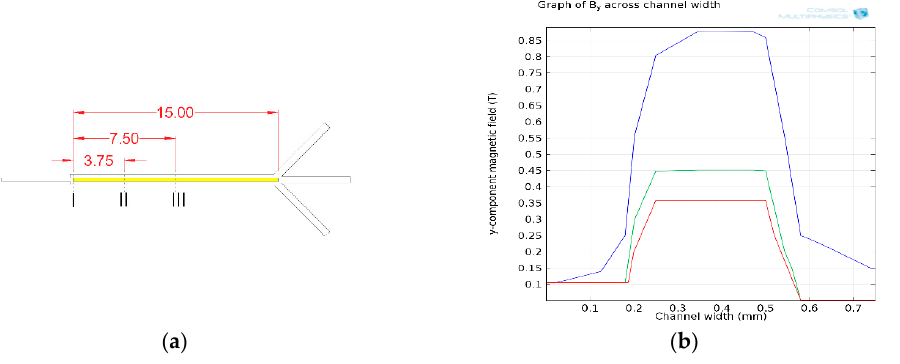
Figure 5. ( a ) Y -component magnetic field analysis at cross section within the microfluidic channel labelled as I, II and III; ( b ) The distribution of B y was plotted across the channel width.